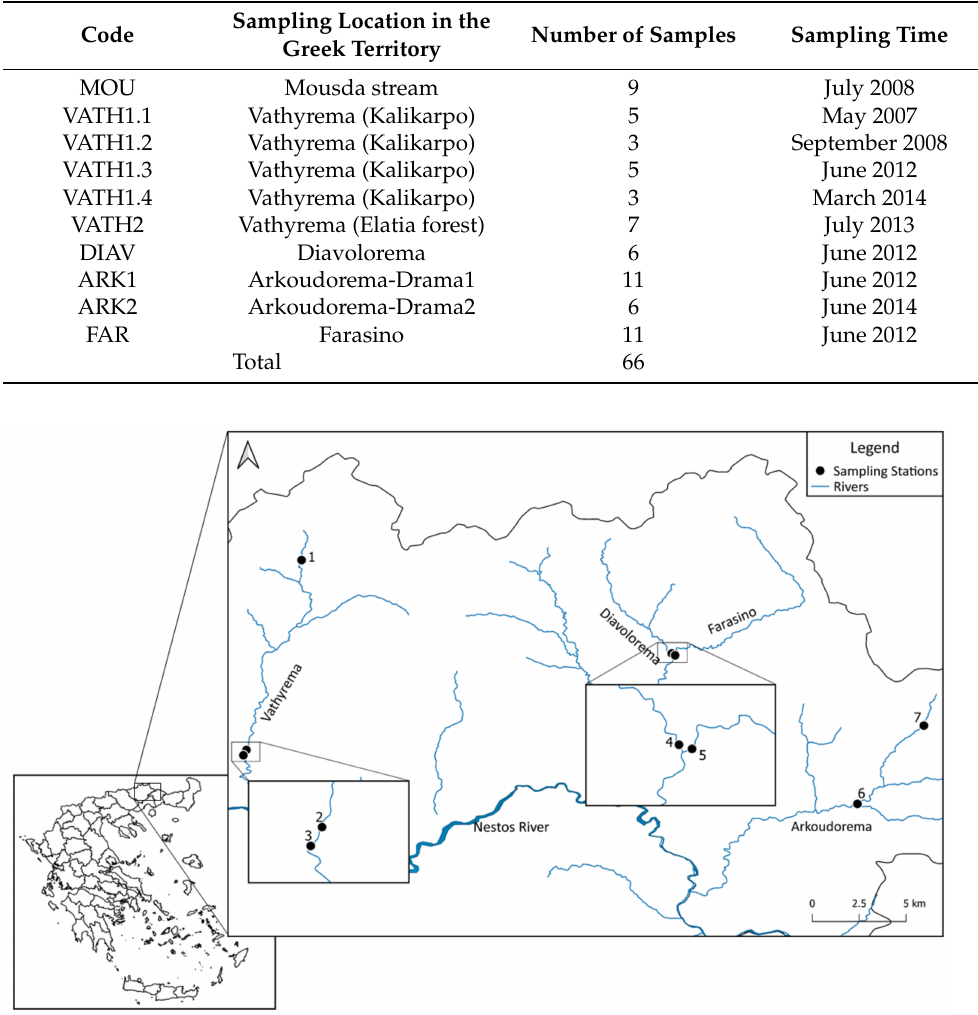
Figure 1. Nestos tributaries (southern Balkans) where the trout samples were collected. Sam- pling stations are indicated as a black dot [1. Vathyrema (Elatia forest), 2. Vathyrema (Kalikarpo), 3. Mousda stream, 4. Diavolorema, 5. Farasino, 6. Arkoudorema-Drama1, 7.